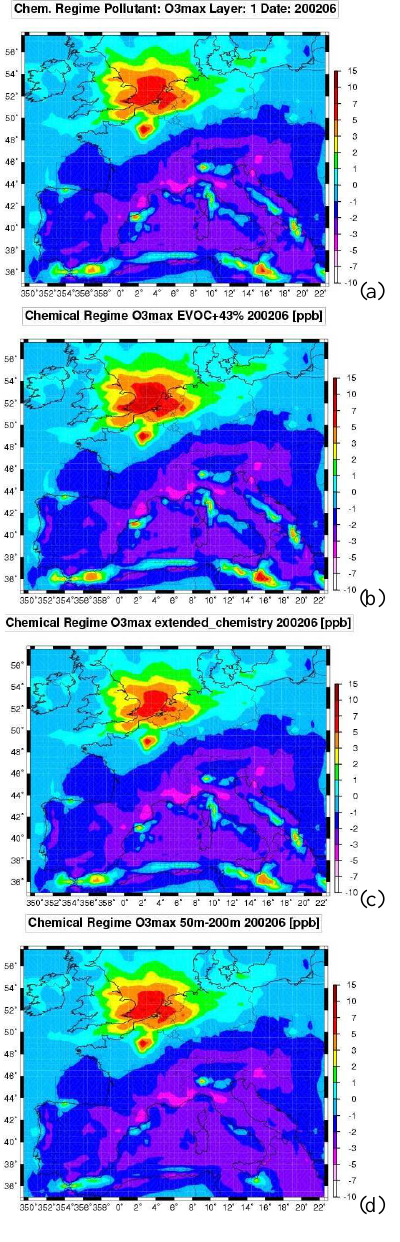
Fig. 9. Sensitivity of chemical regime simulations with respect model configuration and input data (for June 2002 and with respect to daily ozone maximum): (a) reference, (b) with anthropogenic VOC emissions increased by 40%, (c) with the extended MEL- CHIOR chemical mechanism instead of the reduced one, (d) results analysed in model layer 2 (50–200m height) instead of layer 1 (0– 50m